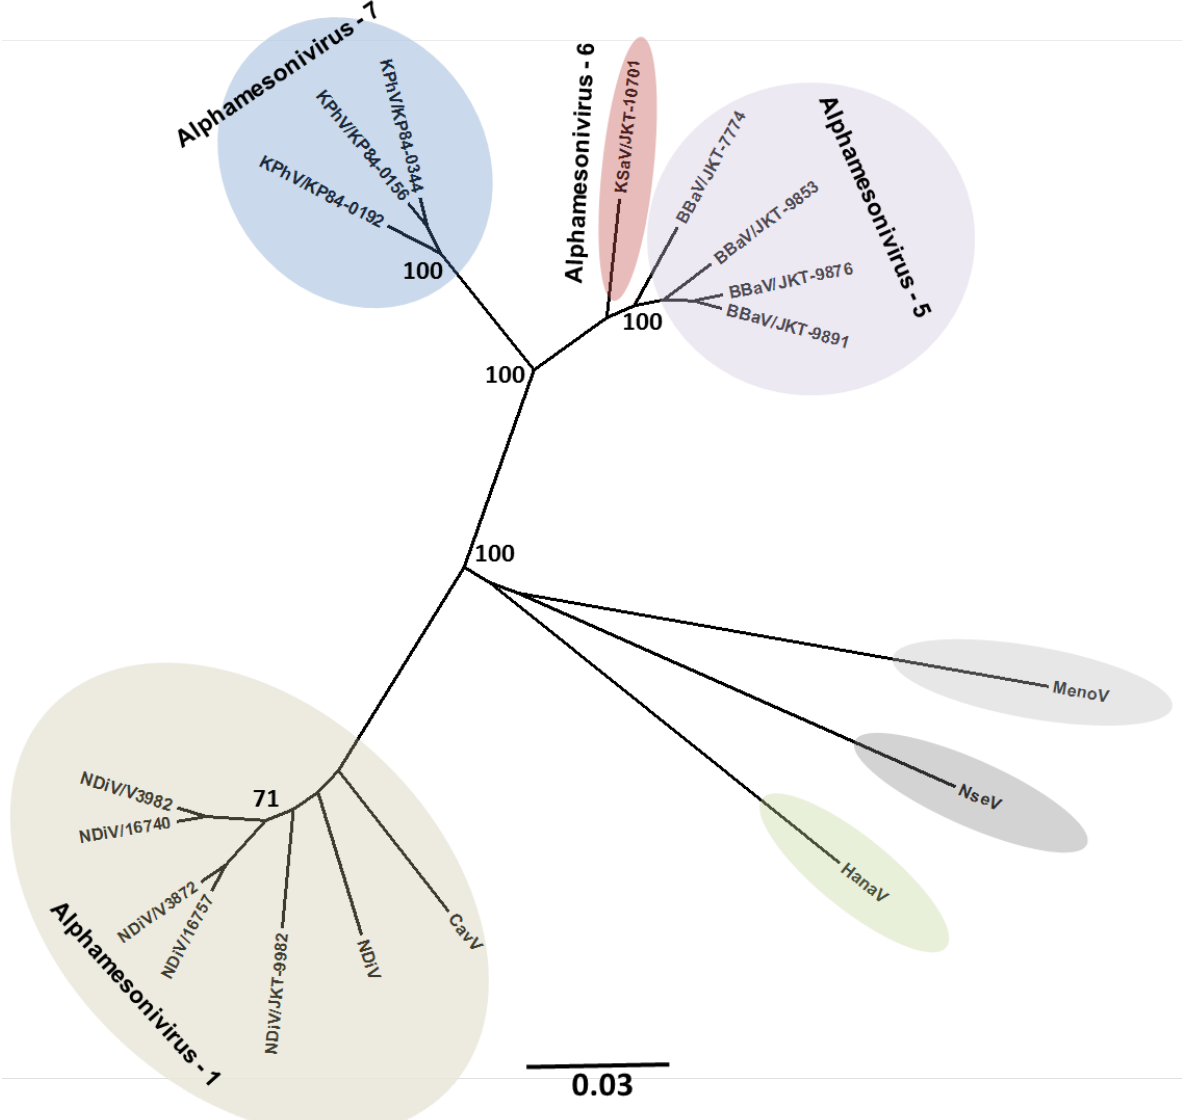
Figure 4. Mesoniviruses: Maximum-likelihood analysis of conserved protein domains of ORF1ab (3CLpro, RdRp, HEL1). Scale bars indicate amino acid substitutions/site. Branch labels indicate virus abbreviation/strain. Additional virus isolate information is contained in a supplemental file. (Adapted from [44]).